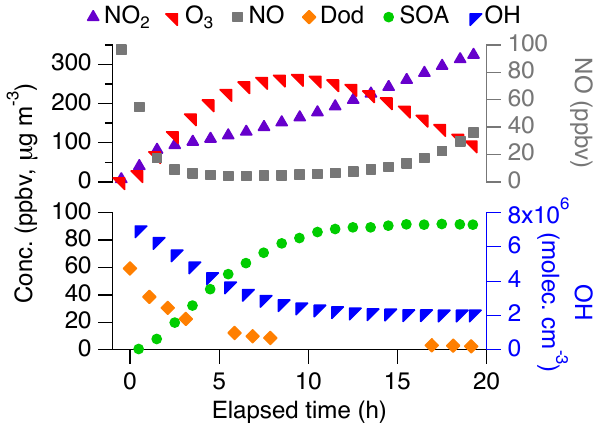
Fig. 1. Temporal trends of gas-phase species and SOA mass con- centration during a typical high-NO x experiment. On the left axis, SOA mass concentration (lower limit) is reported in µgm − 3 , and dodecane, O 3 , and NO 2 mixing ratios are reported in ppbv. NO and OH concentrations are given on the right axis. NO 2 , O 3 , NO, SOA mass, and OH concentrations are hourly averaged. Data are shown for the 57ppbv dodecane experiment, DH2 (see Table 2). OH con- centration was calculated from the dodecane